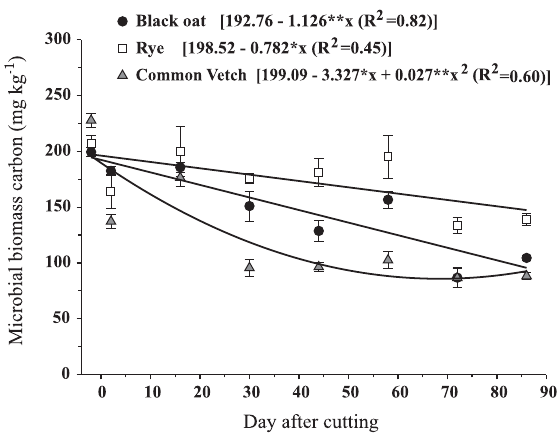
Figure 4. Carbon stored in soil microbial biomass at different times during decomposition of cover plant residues in no tillage system. Error bars represent the standard error around each treatment